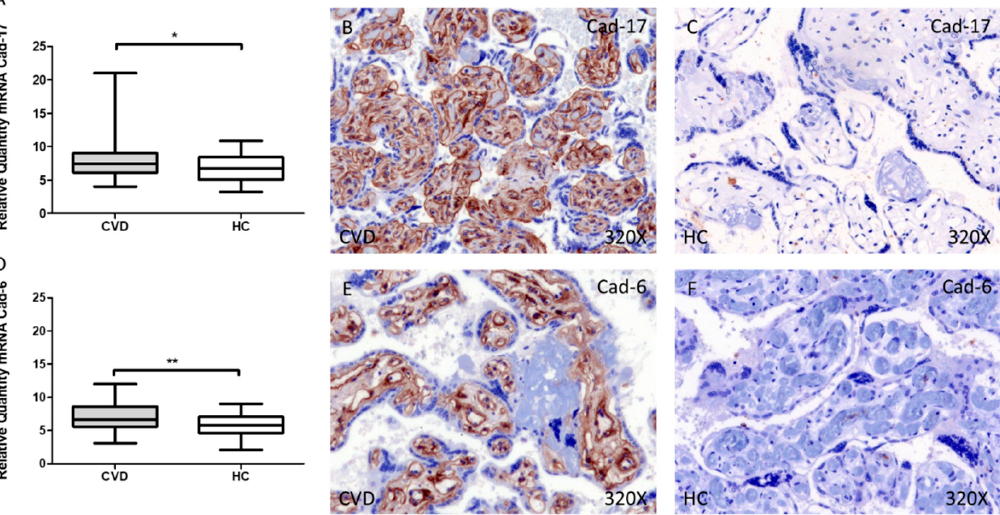
Figure 2. Levels of mRNA for Cad-17 ( A ) and Cad-6 ( D ) quantified by RT-qPCR, and histological imágenes for immunohistochemical techniques in the placental villi in of women with CVD during pregnancy and HC for Cad-17 ( B , C ) and Cad-6 ( E , F ). CVD = Chronic venous disease, HC = Healthy control. p < 0.05 (*), p < 0.01